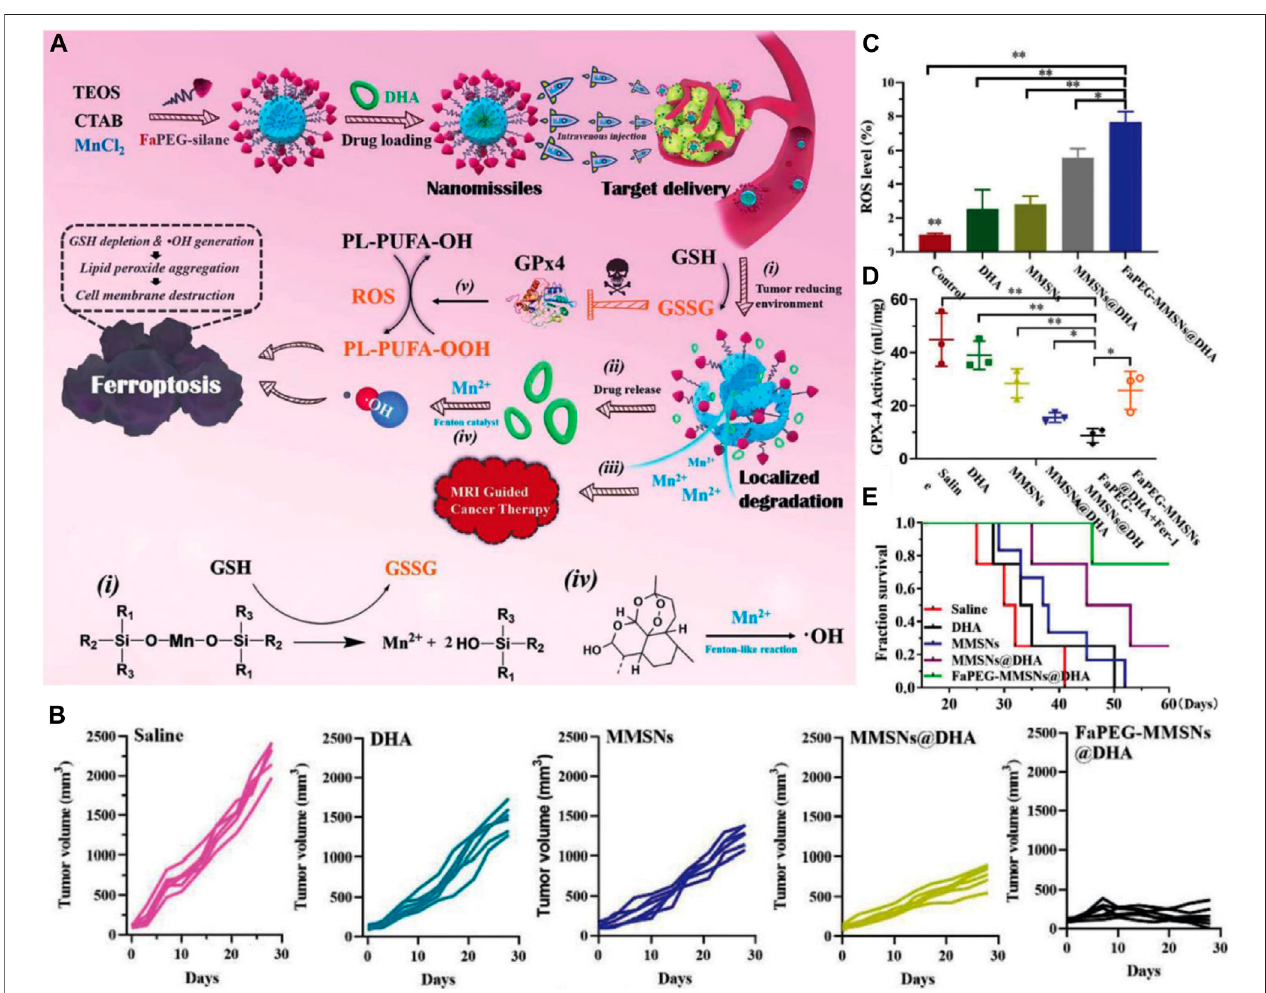
FIGURE 7 | (A) Schematic illustration of the construction and ferroptosis-inducing mechanism of FaPEG-MMSNs@DHA (described as nanomissiles). (B) Time- dependent HepG 2 tumor growth pro fi les. (C) Enhanced ROS generation in the tumor site. (D) GPx4 activity in tumors after different treatments. (E) The survival curve of mice after various treatments. Reprinted with permission from Fei et al. (2020a). Copyright (2020) Royal Society of